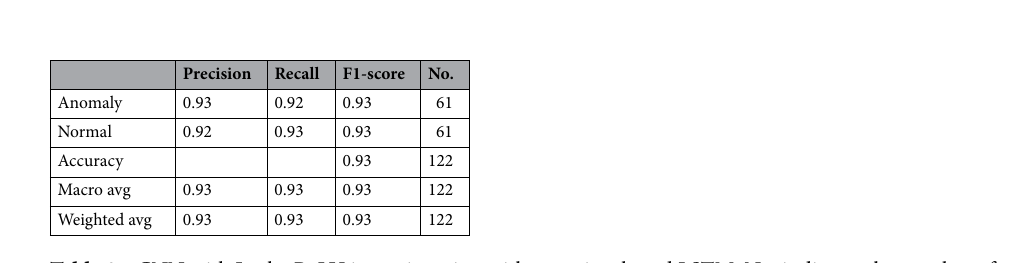
Table 3. CNN with Leaky ReLU in conjunction with attention-based LSTM. No. indicates the number of samples.